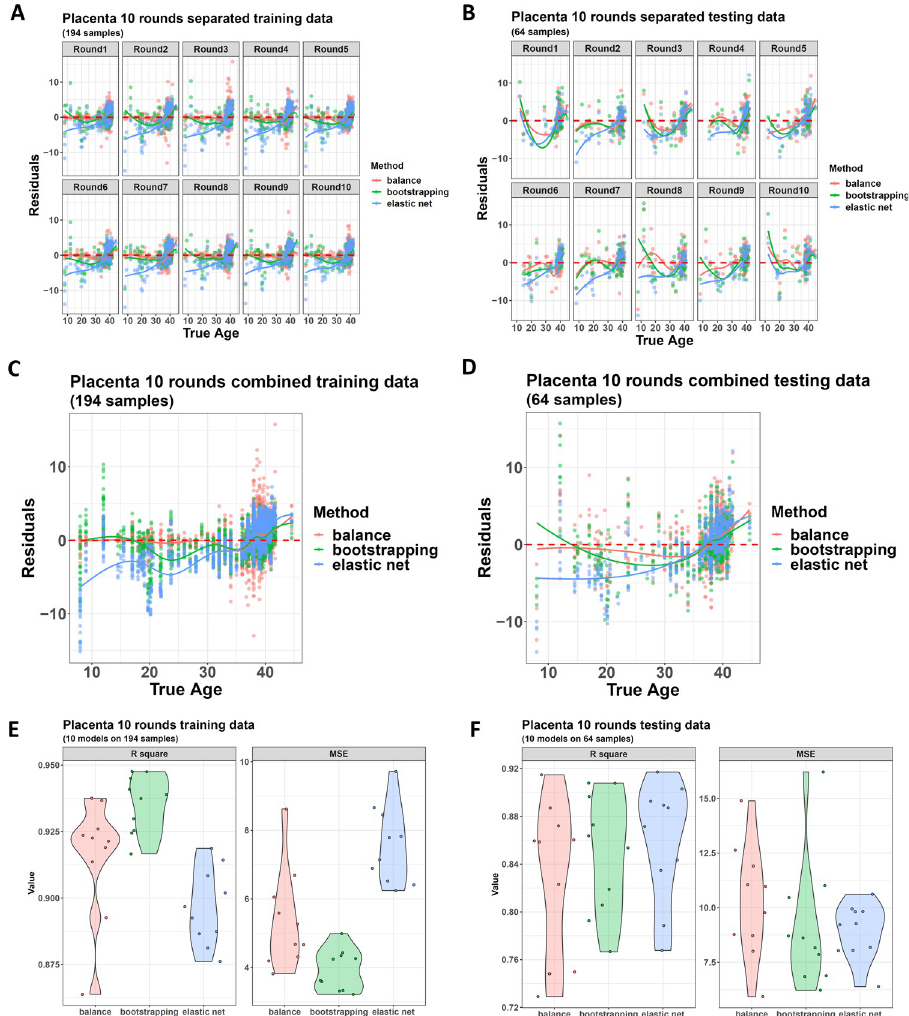
Fig 3. Performance of the three clock algorithms on a 10-round gestational age model construction process. (A) and (B) Residual plots for the 10 new training and 10 new testing datasets generated from the 10 rounds. (C) and (D) Averaged residual curves after combining all the residuals in the 10 rounds for training and testing datasets, respectively. (E) and (F) R squares and MSEs (mean squared errors) for the models generated in the 10 rounds.